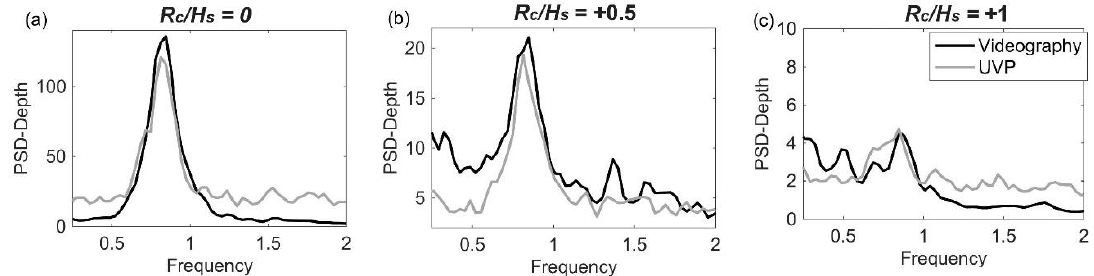
Figure 7. Comparison between water depth spectrum resulting from videography (black line) and UVP data (grey line) at D1: R c /H s = 0 ( a ), +0.5 ( b ) and +1 ( c ). Test with H s = 0.05 m, s m − 1,0 = 3%, G c = 0.30 m and cot(α off ) = 4.